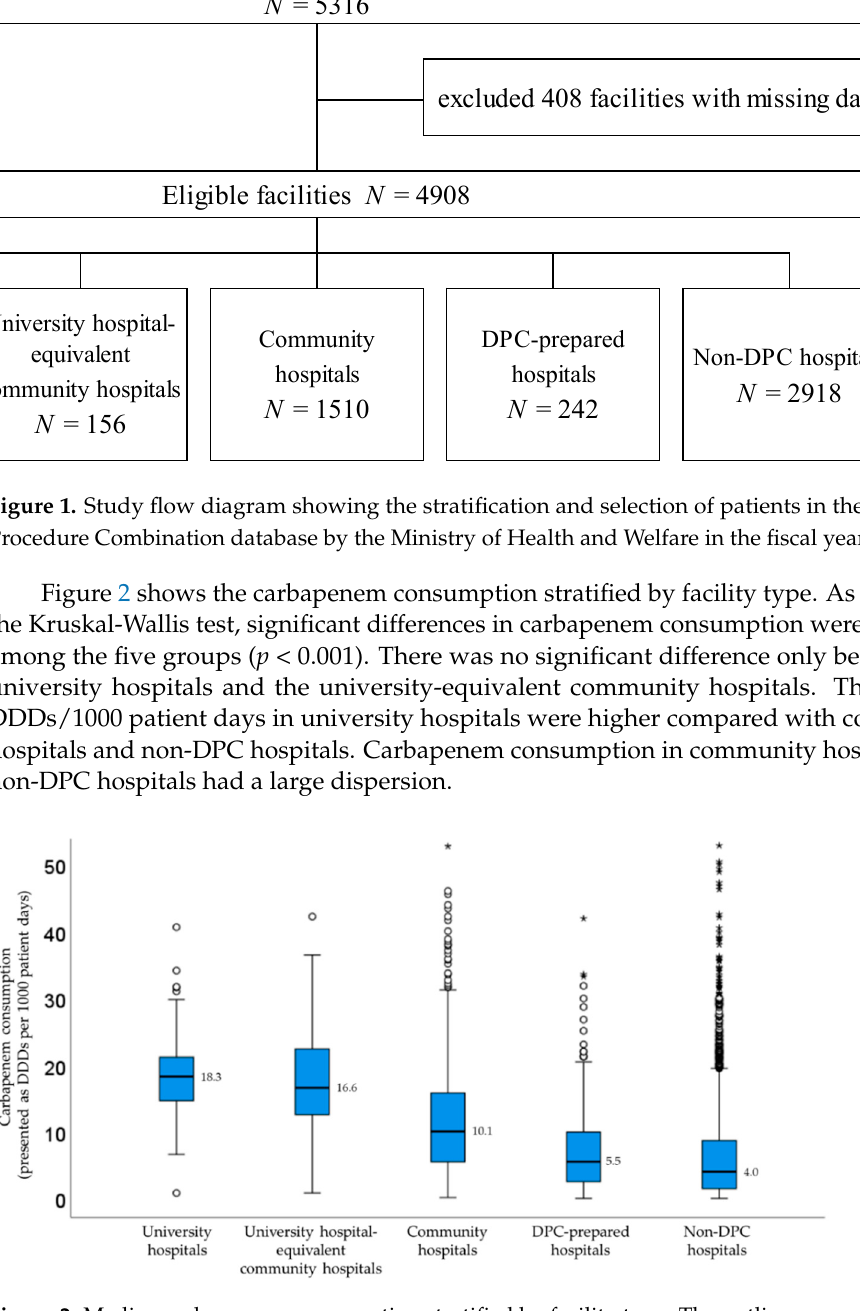
Figure 2. Median carbapenem consumption stratified by facility type. The outliners were plotted on the box plot as a small circle and a star.